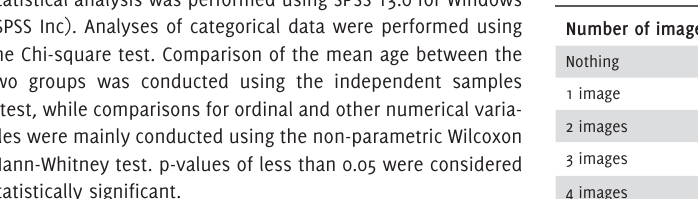
Table 3. Number of Visual Sensation Reported by